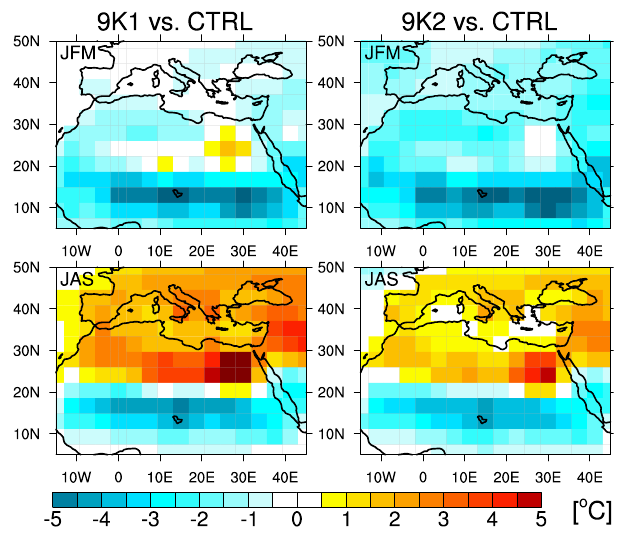
Fig. 7. Anomalies of 2-meter air temperature for winter (JFM) and summer (JAS) from global simulations, 9K1 vs. CTRL (left) and 9K2 vs. CTRL